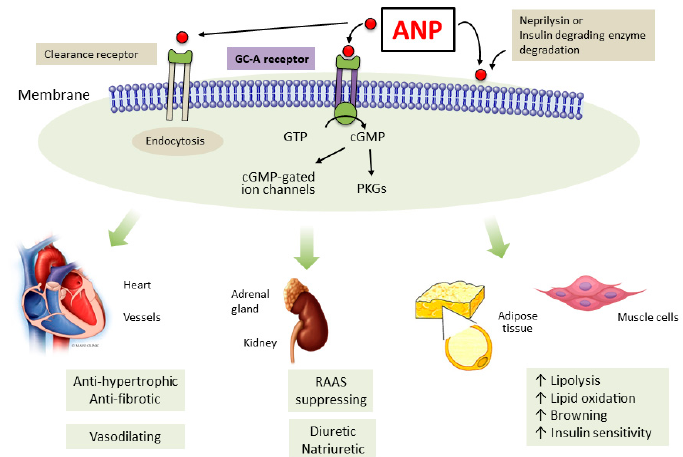
Figure 1. Atrial natriuretic peptide binds to the guanylyl cyclase A receptor (GC–A) resulting in the production of the second messenger cyclic guanosine monophosphate (cGMP). Protein kinase G (PKG) and cGMP-gated ion channels are then activated and mediate ANP biological actions, which are summarized in the figure.